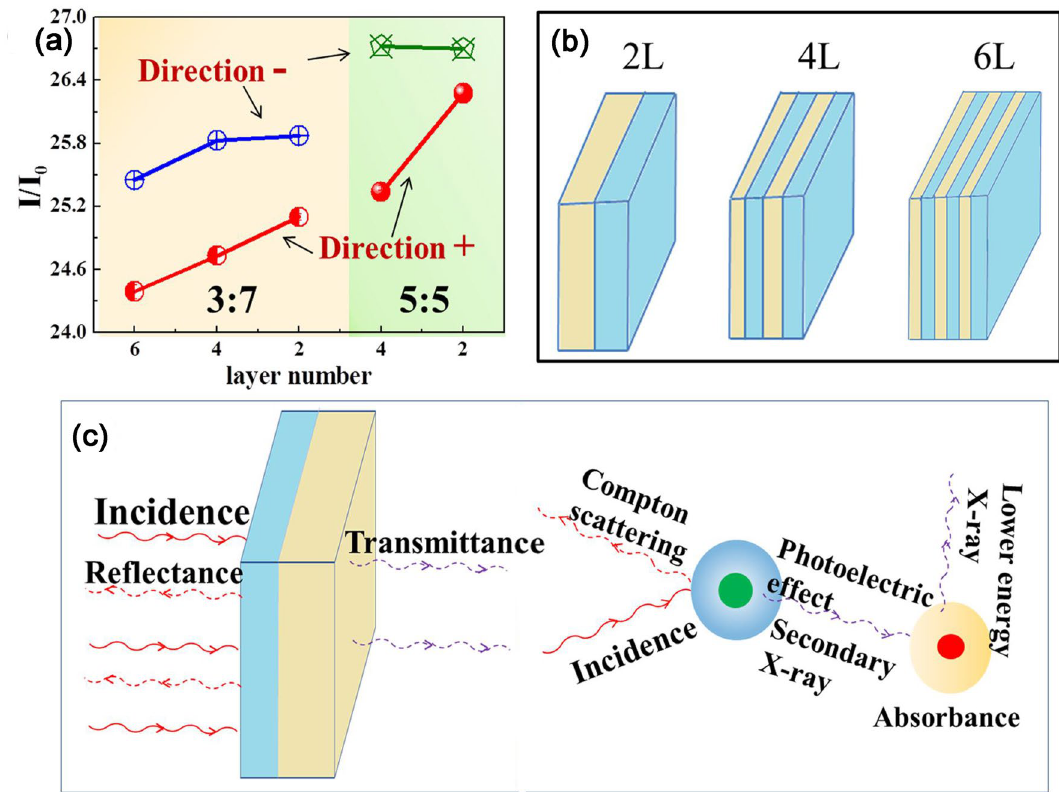
Figure 5. ( a ) The dependence of the X-ray transmittance on layer thickness ratios (4:6 and 3:7), incident direction and number layers. ( b ) the structural schematic of multilayered composite with different number of layers; ( c ) schematic diagram of photon attenuation